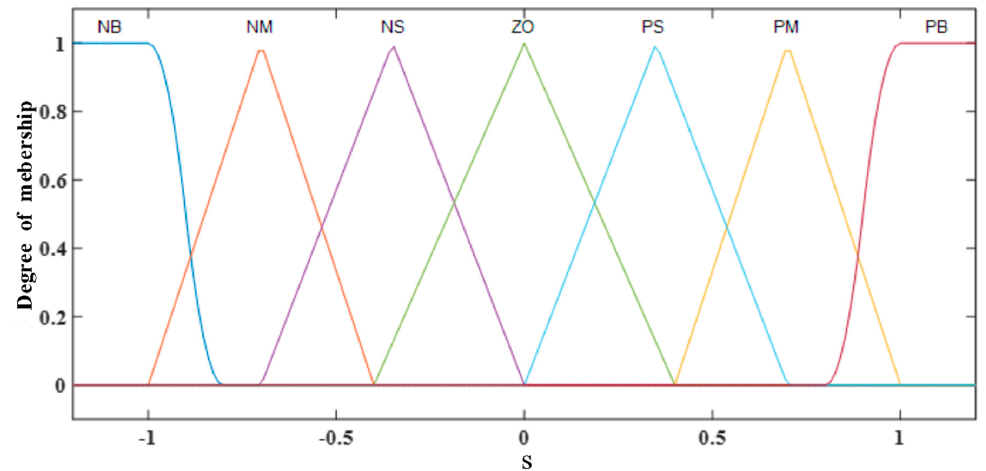
Figure 8. The s membership function diagram.